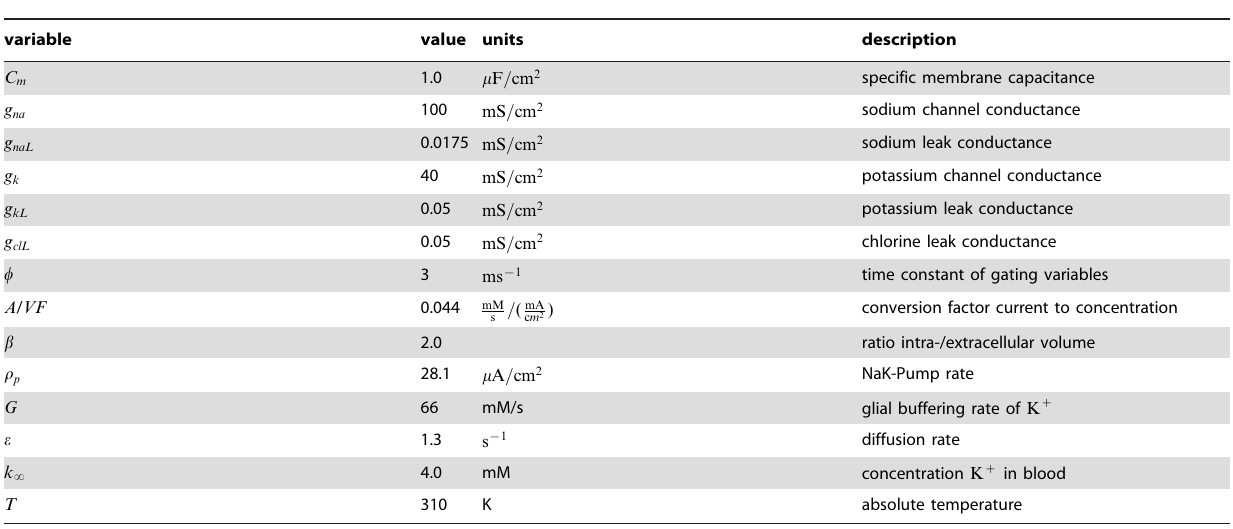
Table 1. Overview of the parameters used in the simulations.